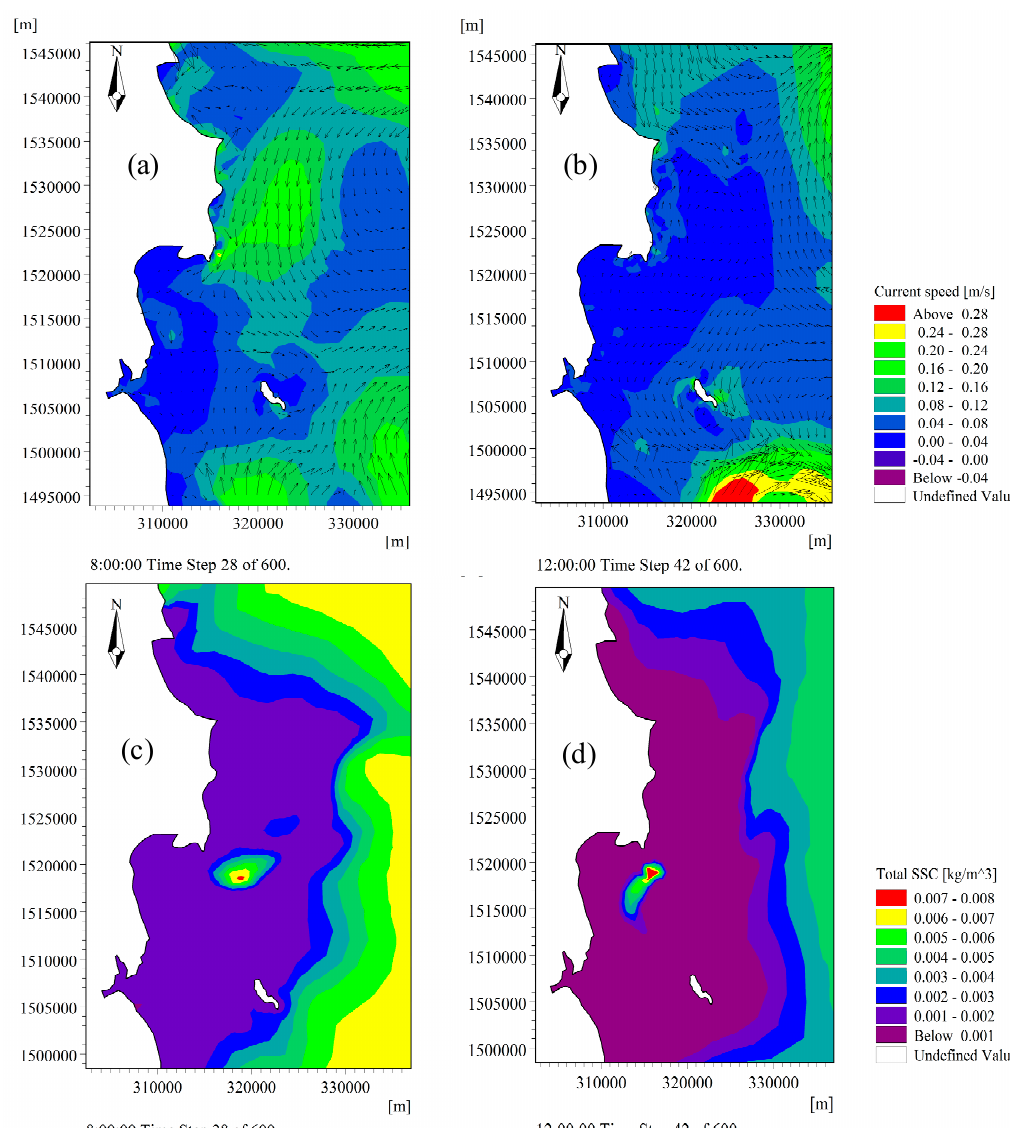
Figure 8. The simulation results of S1. Streamflow field during ( a ) low tide; ( b ) high tide. Distribution of suspended sediment concentration (SSC) during ( c ) low tide; ( d ) high tide .